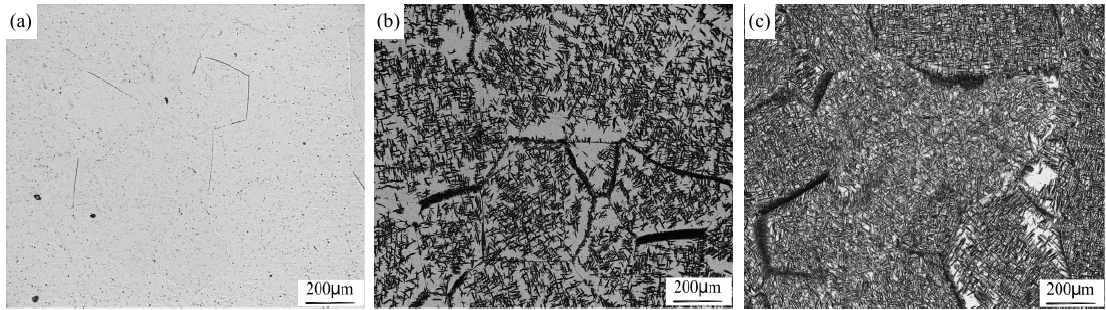
Figure 9. Microstructural developments during isothermal treatment at 700 °C. The specimens were heated to 865 °C and then held for ( a ) 10, ( b ) 60, ( c ) 120 min at 700 °C.